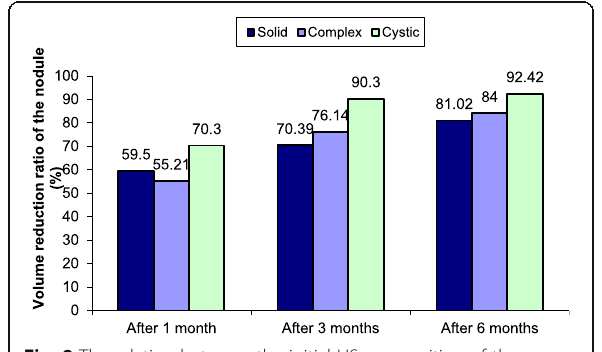
Fig. 8 The relation between the initial US composition of the thyroid nodules and the volume reduction ratio after RF ablation